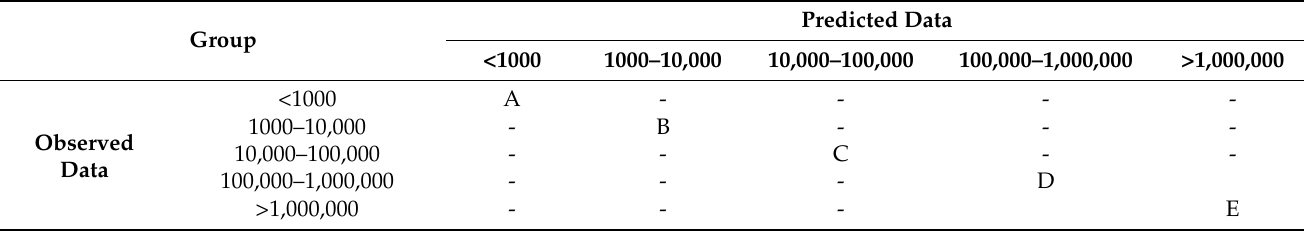
Table 8. Method for calculating the success rate of the harmful cyanobacteria